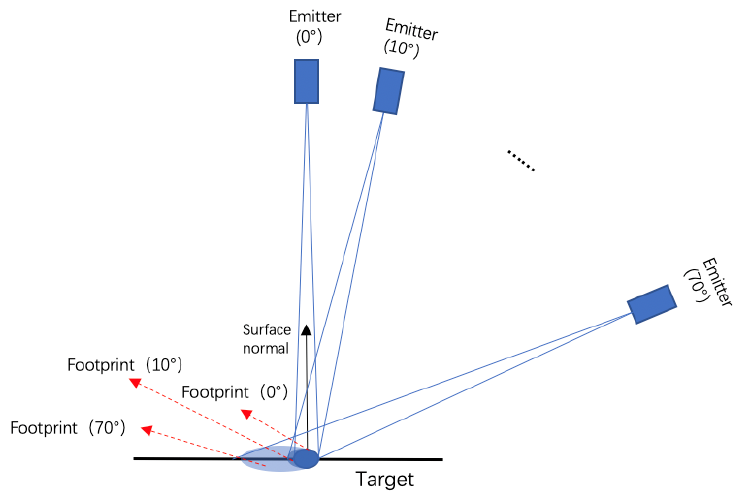
Figure 13. The change of size of laser footprint with incident angle.